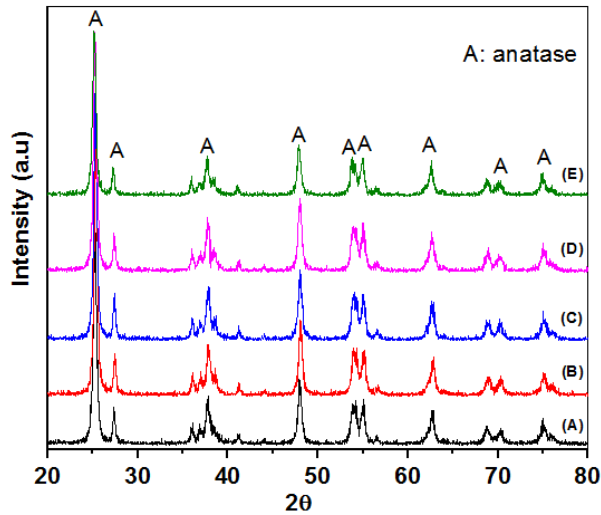
Figure 2. X-ray diffraction patterns of ( A ) 1% Pd/TiO 2 , ( B ) 1% Cu/TiO 2 , ( C ) 0.75Pd-0.25Cu/TiO 2 , ( D ) 0.25Pd-0.75Cu/TiO 2 ( E ) 0.5Pd-0.5Cu/TiO 2 .